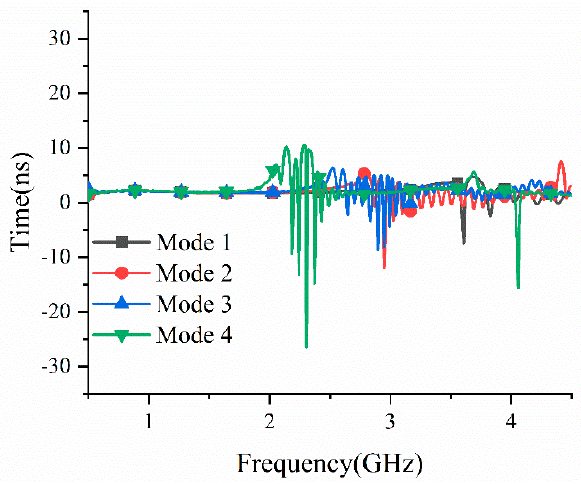
Figure 13. The measured group delay of the proposed antenna.